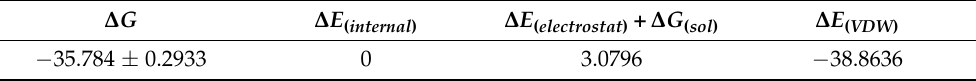
Table 6. The binding-free energy (kcal/mol) of the complex calculated using MM/GBSA method. ∆